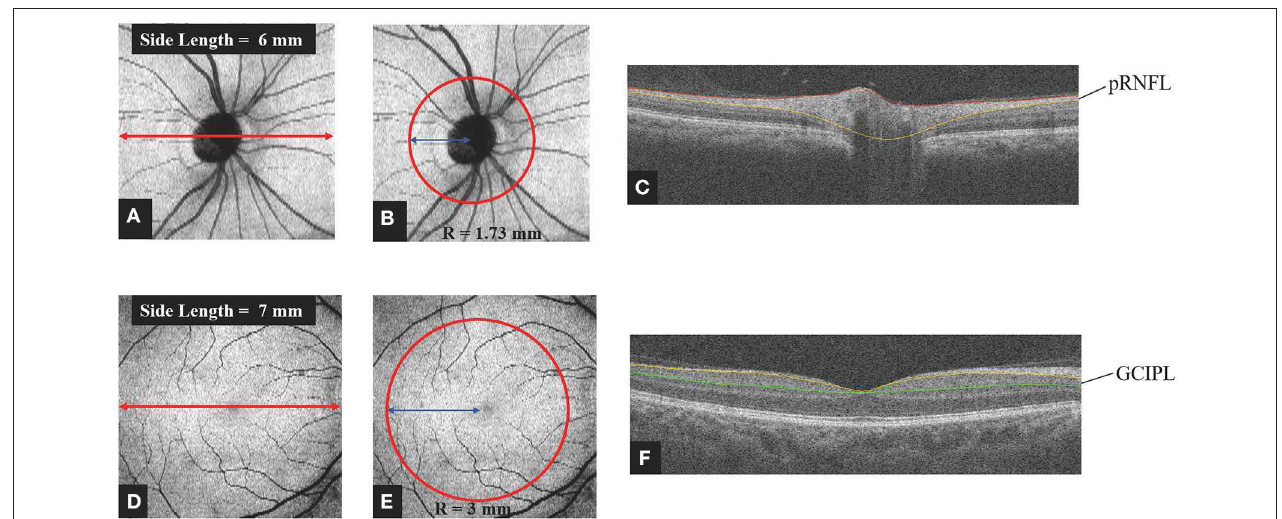
FIGURE 1 | Method of obtaining retinal thickness. (A) Representative image captured by the 3D Disc protocol of spectral domain OCT. The image was centered on the optic disc and covered a square grid (6 × 6mm). (B,C) For analysis of the pRNFL thickness, further segmentation was done automatically by layering software that was centered on the optic disc and covered a circle 1.73mm in radius. Manual correction was not employed. (D) Representative image captured by the 3D Retina protocol of spectral domain OCT. The image was centered on the macula and covered a square grid (7 × 7mm). (E,F) For analysis of the GCIPL thickness, further segmentation was done automatically by the layering software. The image was centered on the macula and covered a circle 3mm in radius. Manual correction was not employed. OCT, optic coherence tomography; pRNFL, peripapillary retina nerve fiber layer; GCIPL, ganglion cell layer and inner plexiform layer; R,